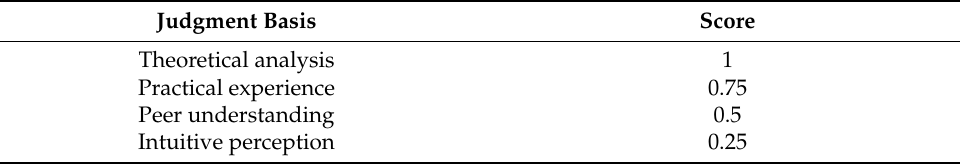
Table 3. Expert Judgment